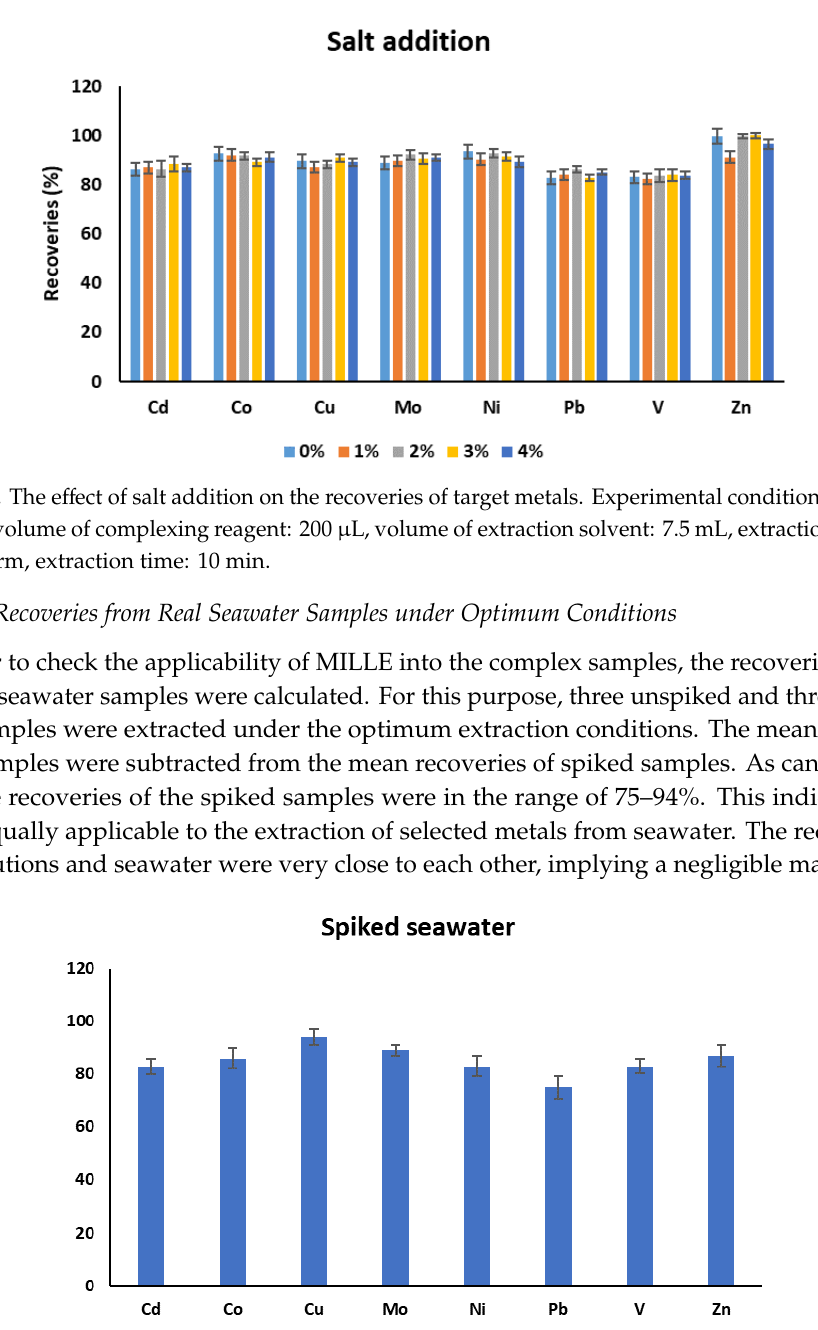
Figure 8. The recoveries of metals from spiked seawater samples. Experimental conditions: sample pH: 4.5, volume of complexing reagent: 200 µ L, volume of extraction solvent: 7.5 mL, extraction solvent: chloroform, extraction time: 10 min.